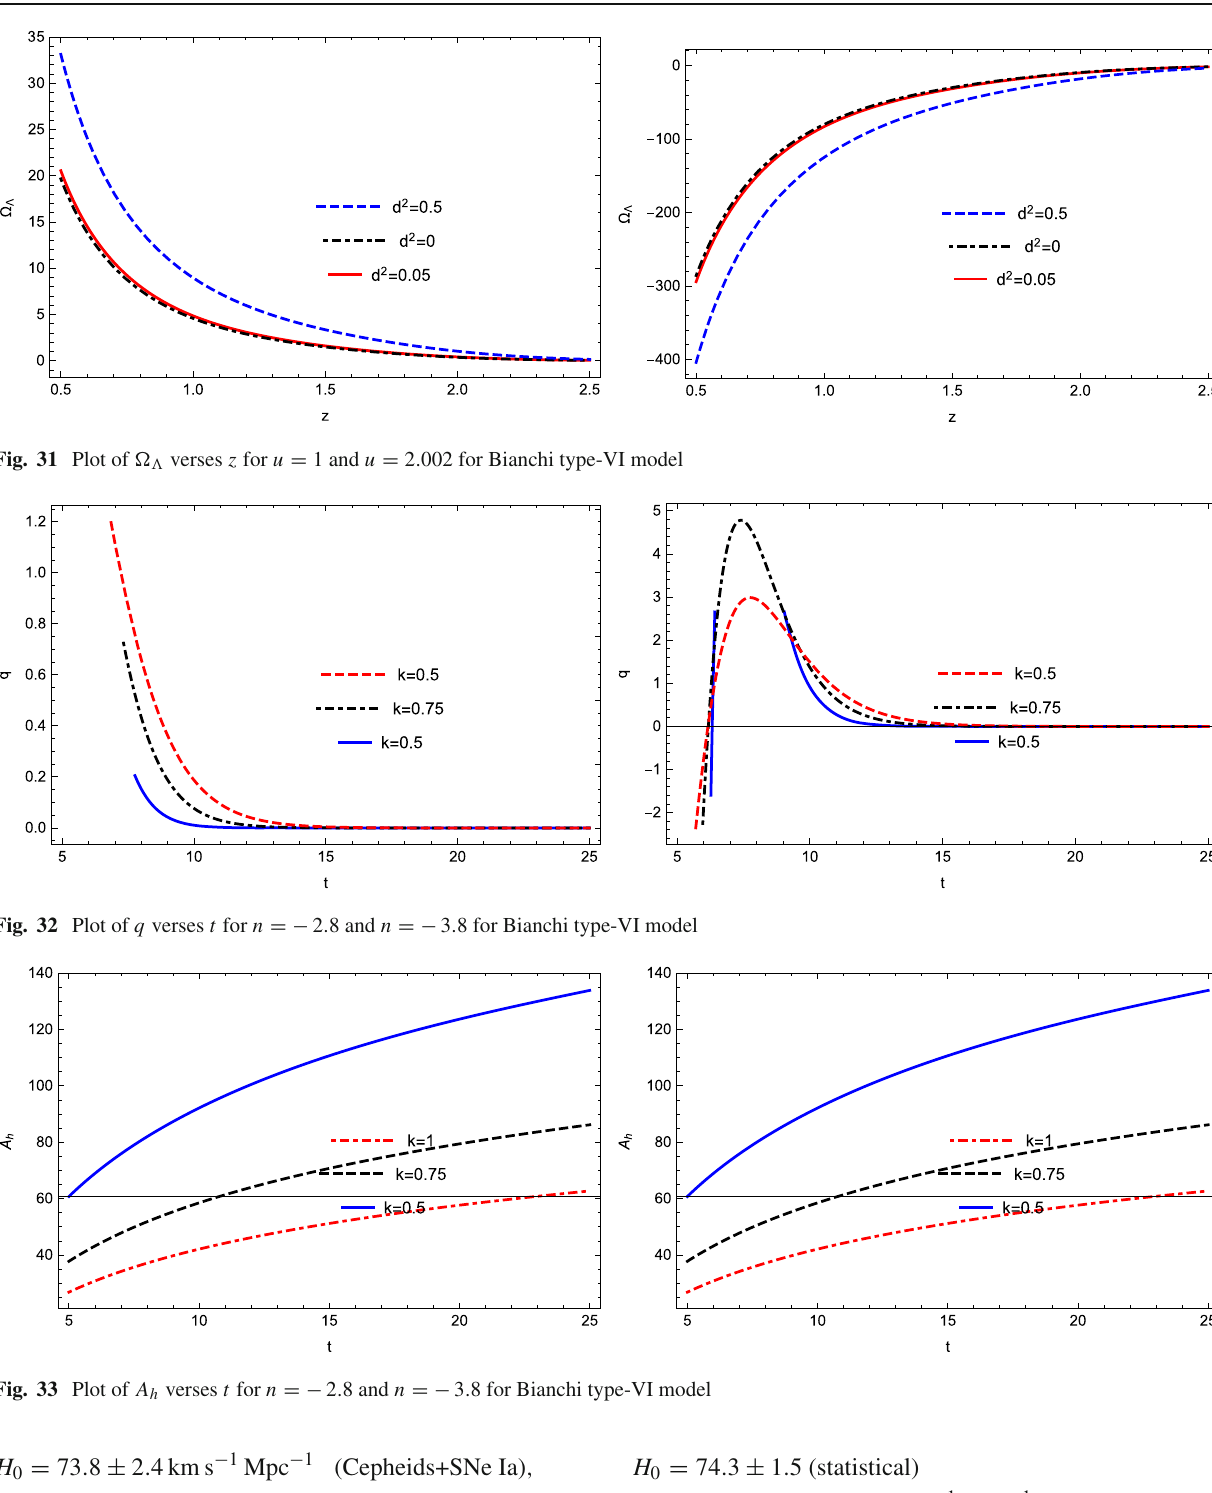
H 0 = 73 . 8 ± 2 . 4 km s − 1 Mpc − 1 (Cepheids+SNe Ia)